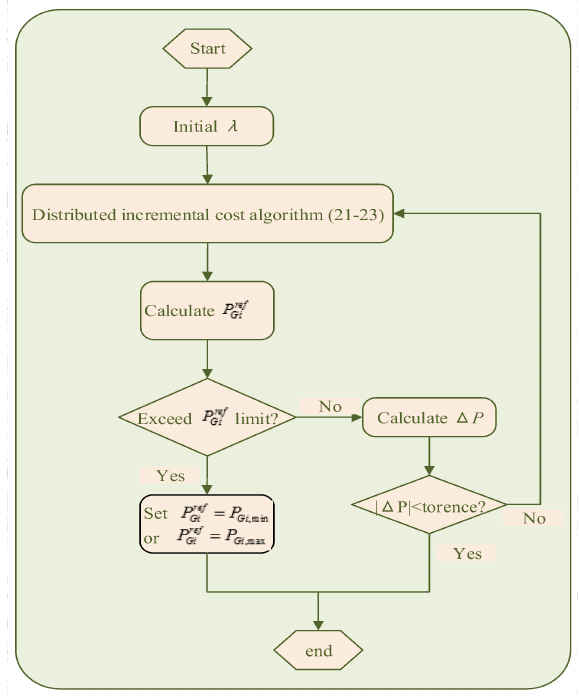
Figure 3. The calculation process of the optimal incremental cost with power